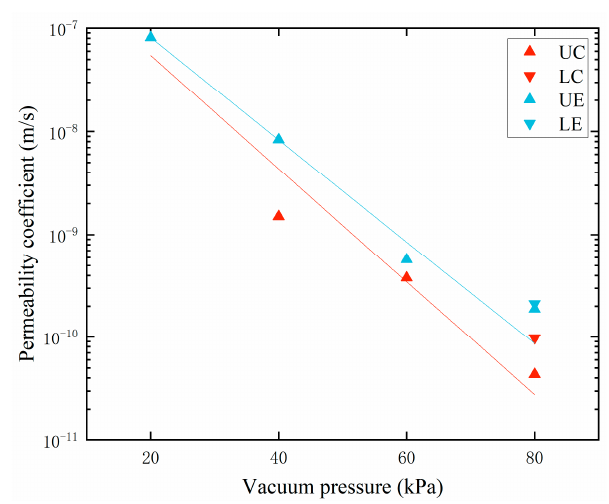
Figure 10. Permeability coefficient in each stage.